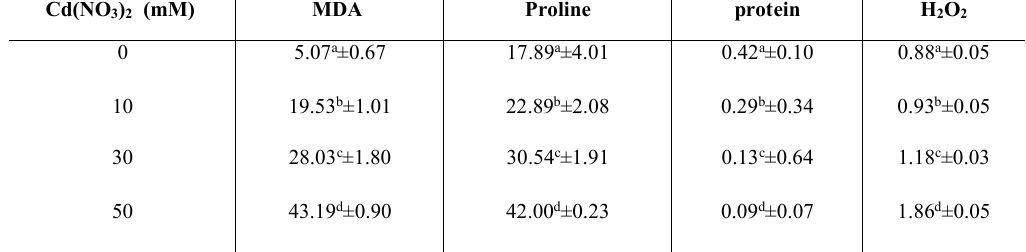
Table 3. Effect of different concentrations of Cd(NO 3 ) 2 on total protein (mg ml -1 ), proline (μM g -1 FW), MDA (μM g - 1 FW) and H -1 FW) content of C. roseus callus cells after treatment for 3 2 O 2 (μM g